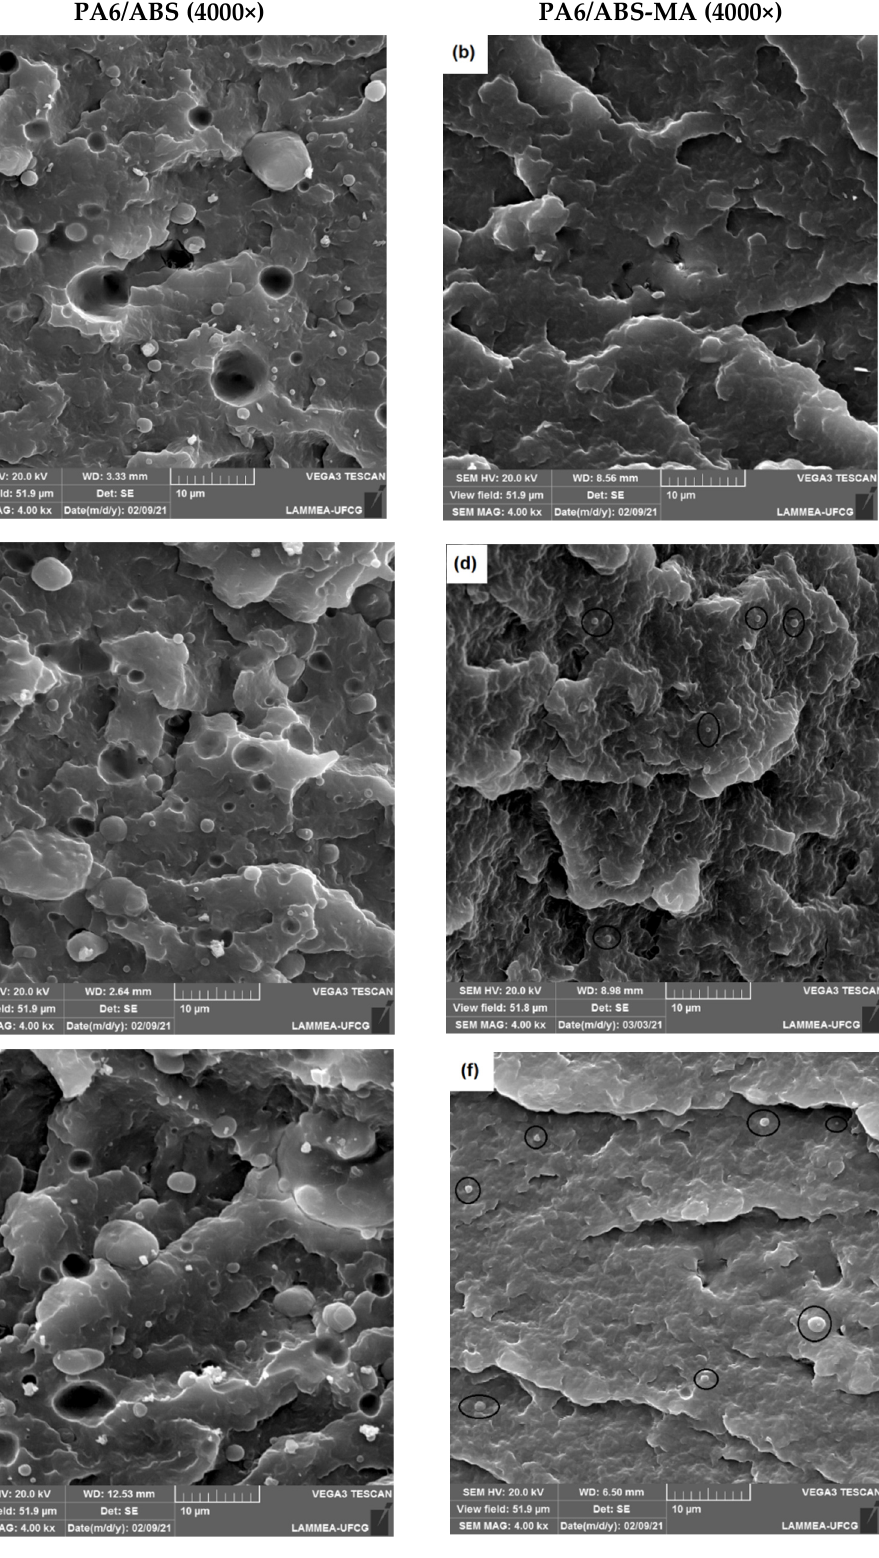
Figure 7. SEM micrographs of the fractured surfaces of ( a ) PA6/ABS (5%); ( b ) PA6/ABS-MA (5%); ( c ) PA6/ABS (7.5%); ( d ) PA6/ABS-MA (7.5%); ( e ) PA6/ABS (10%); ( f ) PA6/ABS-MA (10%), respectively.